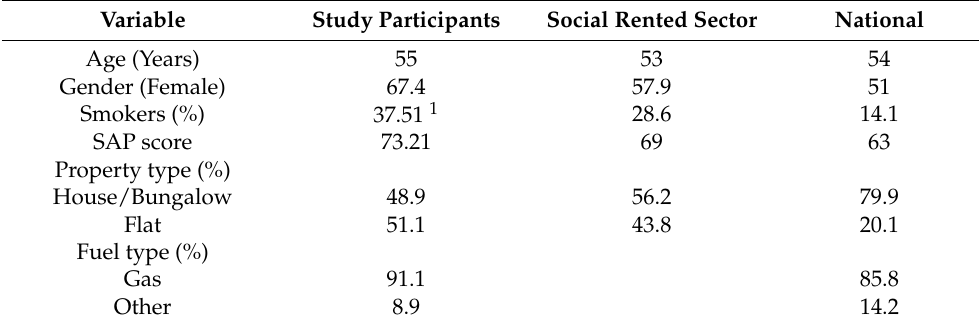
Table 1. Comparison of study participant and building characteristics with national and social rented sector averages [57,58,66–69]. Variable Study Participants Social Rented Sector National Age